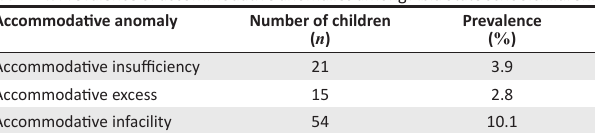
TABLE 4: Prevalence of accommodative anomalies among Abia State schoolchildren. Accommodative